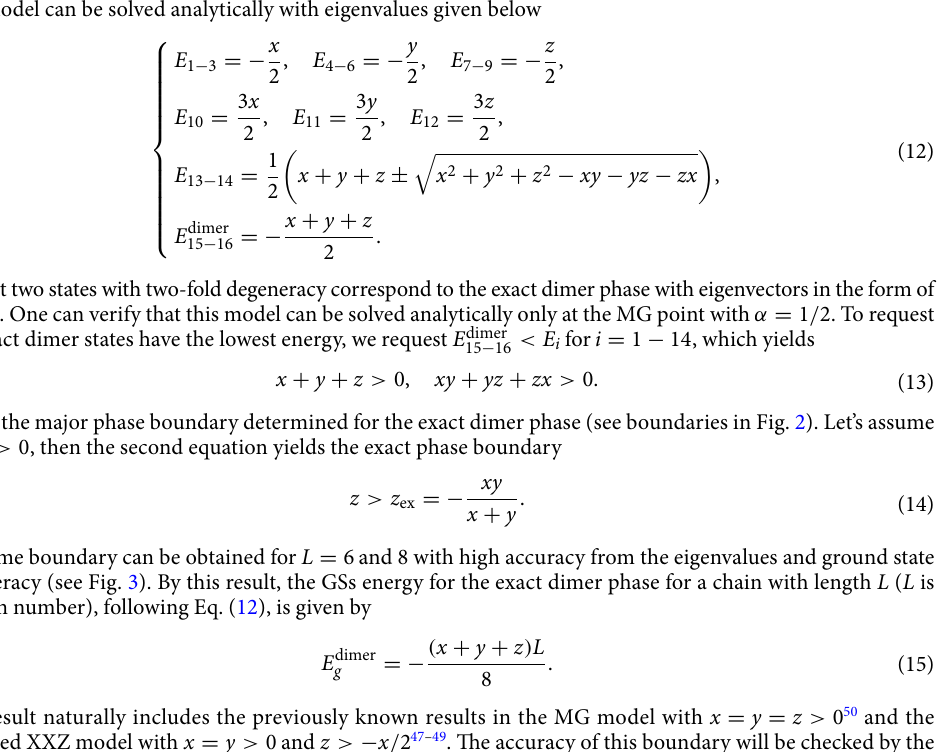
4 . In the exact dimer phase, the deep red regions can not be 10 − ×